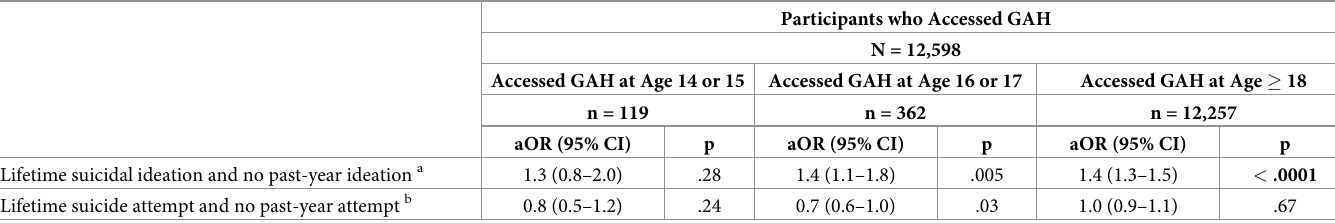
Mental health outcomes of transgender adults who recalled access to gender-affirming hormones (GAH) during various age groups. Reference group for all analyses is participants who desired GAH but did not access them. Both models adjusted for age, partnership status, employment status, K-12 harassment, and having experienced gender identity conversion efforts. a Model also adjusted for gender identity, sex assigned at birth, sexual orientation, race/ethnicity, family support of gender identity, educational attainment, and total household income. b Model also adjusted for gender identity, sex assigned at birth, sexual orientation, race/ethnicity, family support of gender identity, educational attainment, total household income, and having received pubertal